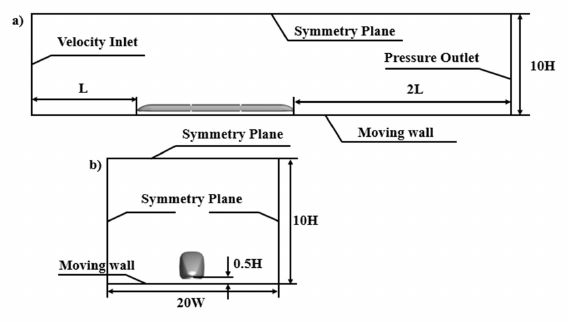
Fig. 4. Computational domain and boundary